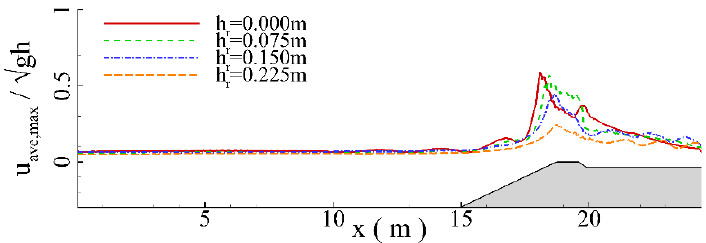
Figure 37. Space distributions of the local maximum depth-averaged velocity.